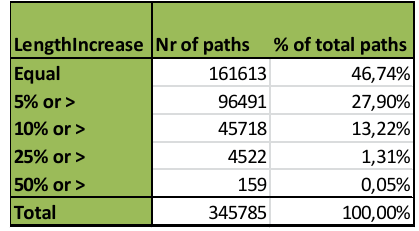
Figure 3: Classification of paths